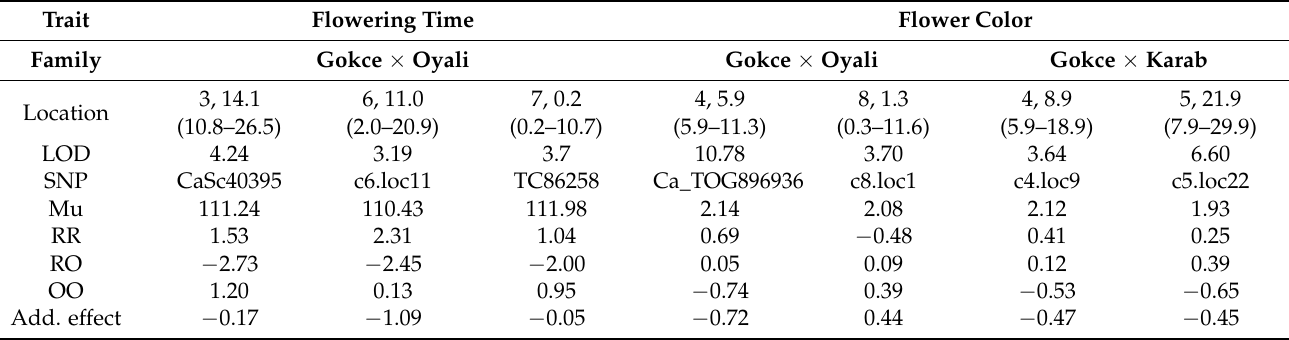
Table 4. Summary of quantitative trait loci for flowering time and flower color for two chickpea NAM populations. Locations are described by chromosome number, position in 1M bp units, and 95% confidence limits in parentheses. LOD is the logarithm of the odds score. SNP is the marker nearest to the QTL peak. SNPs named c#.loc# are genotype probabilities at 1M bp map intervals. Mu is the model-predicted mean trait value. Units are days for flowering time or a score of 1 for cultivated white, 2 heterozygous white and purple, and 3 for wild purple for flower color. Genotype effect sizes on the mean phenotype are summarized as R for the reference cultivated allele and O is the other wild allele. Genotype RO is a measure of the dominance effect. The additive effect is calculated as (RR −